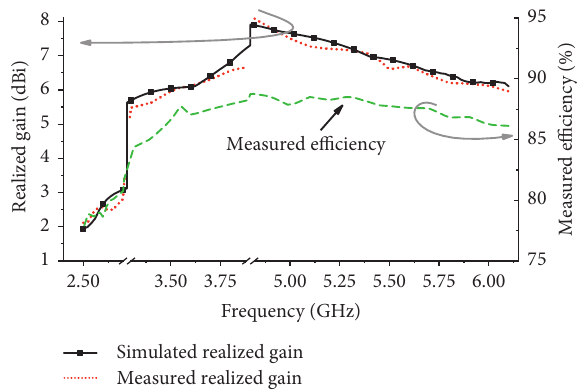
Figure 16: Realized gain and efficiency of the proposed patch antenna. Table 1: Comparison with other antennas having omnidirectional and unidirectional radiation patterns.